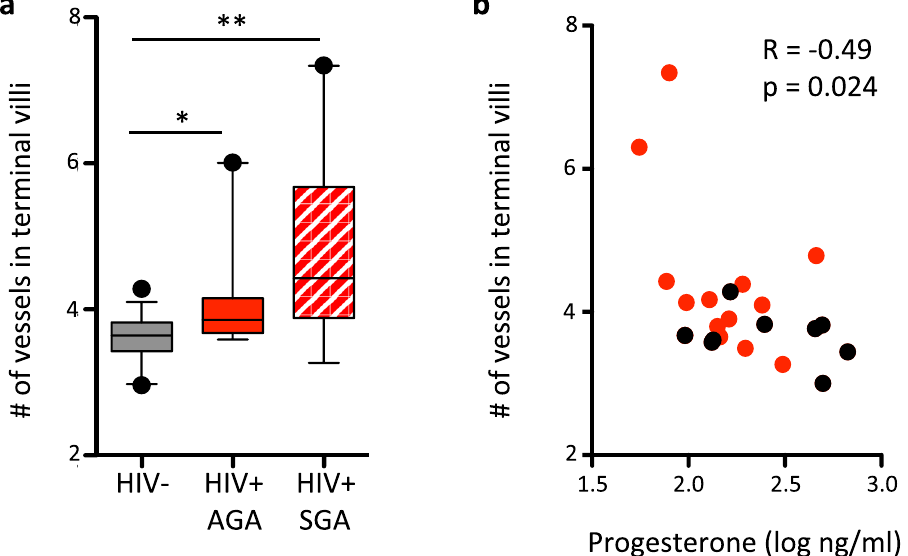
Figure 7. The number of terminal villi capillaries is higher in placenta from HIV-positive women on PI-cART. ( a ) The number of capillaries in immature intermediate and terminal villi was assessed in term placenta sections from HIV-negative (HIV − , grey), HIV-positive women on cART with an average for gestational age (HIV + AGA) birth (solid red), and HIV-positive women on cART with a small for gestational age (HIV + SGA) birth (stripped red). Data shown as box (showing median and interquartile range) and whisker (showing 10 th to 90 th centile) plots. Dots signify values outside the 10 th and 90 th percentile. Statistical comparison by Kruskal Wallis test (p = 0.0076) with Dunn’s post-test, n = 13 for HIV-negative and n = 9 for HIV-positive AGA and n = 9 for HIV-positive SGA. * p < 0.05, ** p < 0.01. ( b ) Correlation between capillary number and progesterone levels in maternal blood at delivery. Correlation assessed by Pearson R